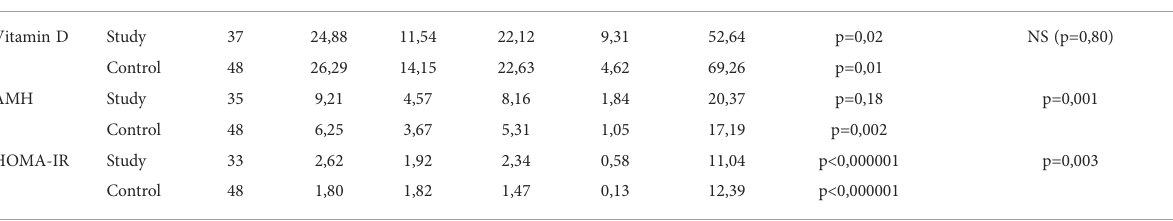
TABLE 3 Vitamin D3, AMH, HOMA-IR level in the study and control group. Parameter Group Group size Mean